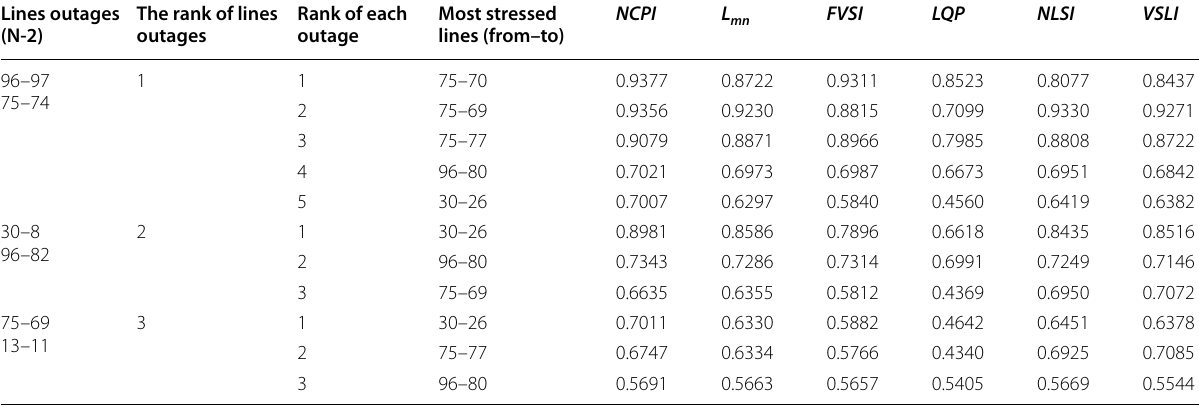
Table 12 Contingency ranking and analysis of the IEEE 118-bus system with two lines outages and pre-specified reactive power load at nodes 11, 20, 30, 33, 51, 75 and 96 343 MVAr = Lines outages